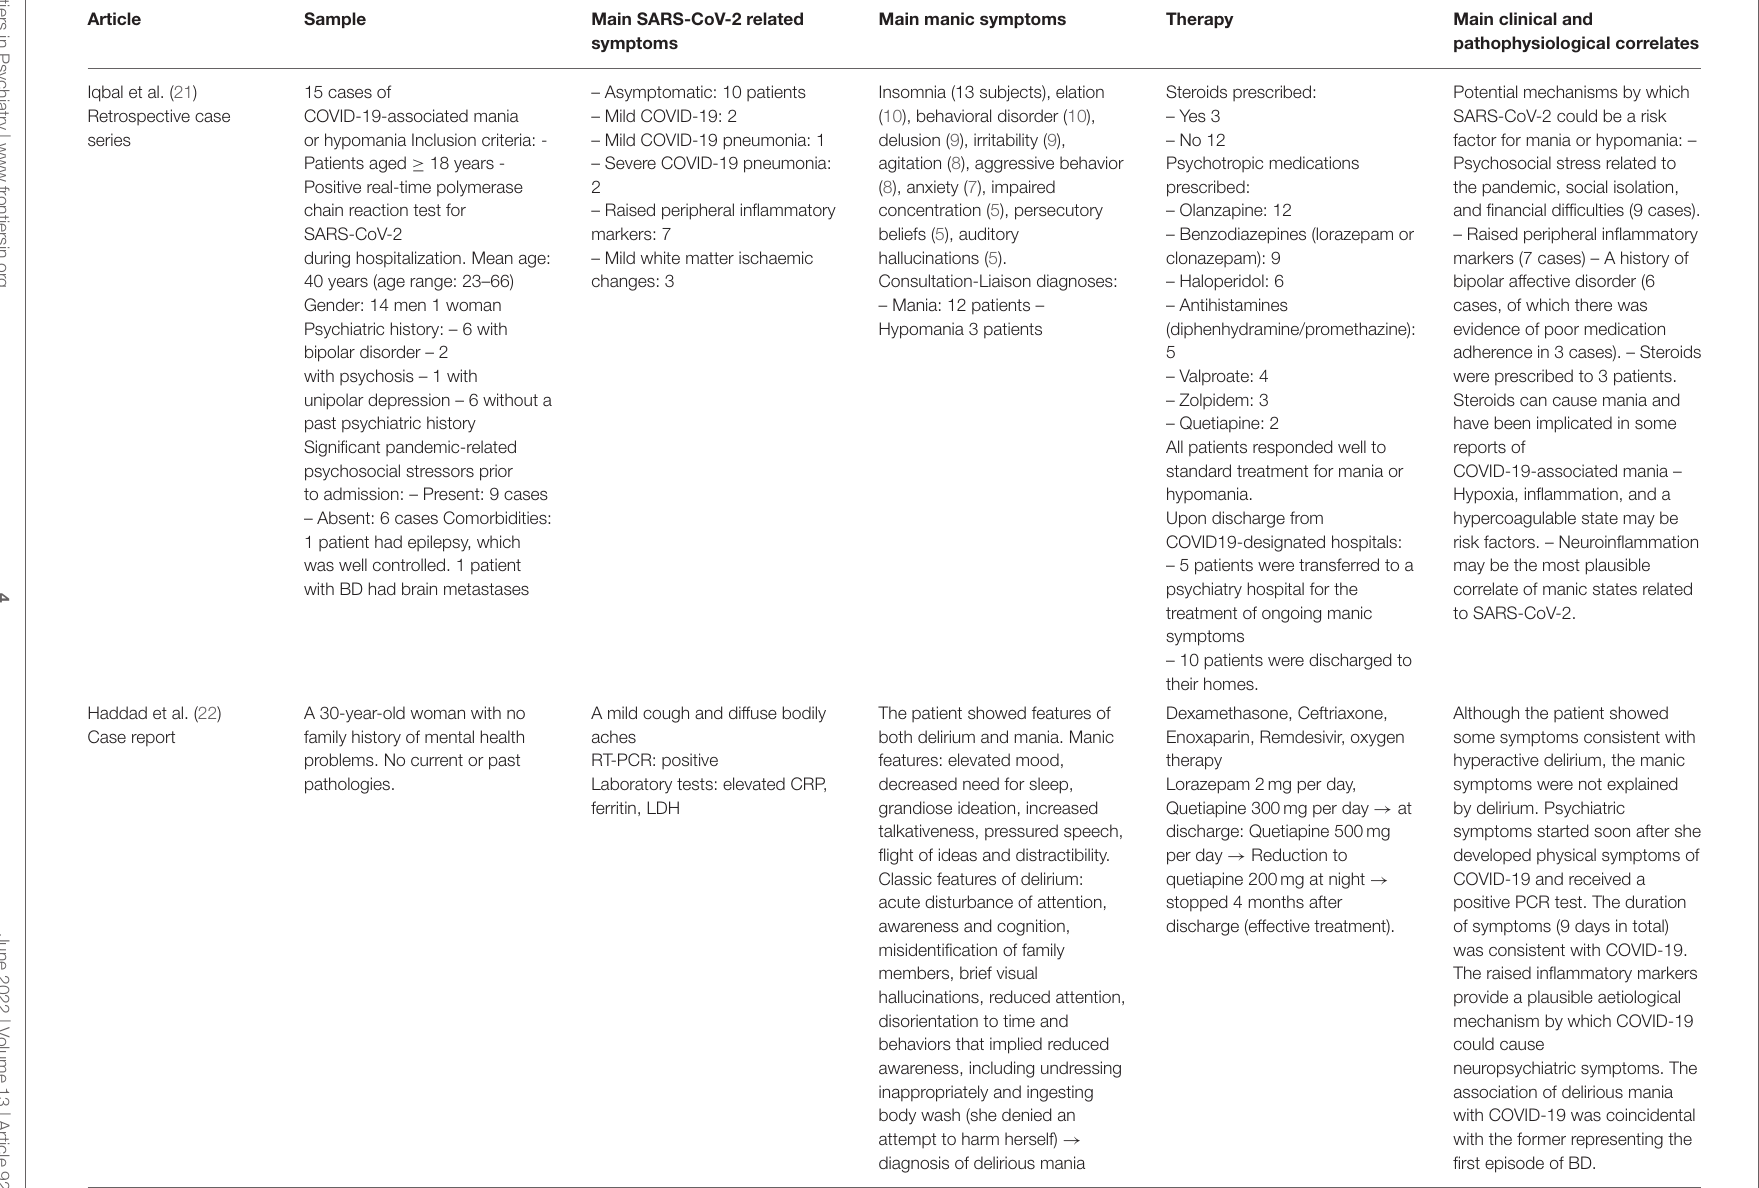
TABLE 1 | Studies of manic episodes comorbid with